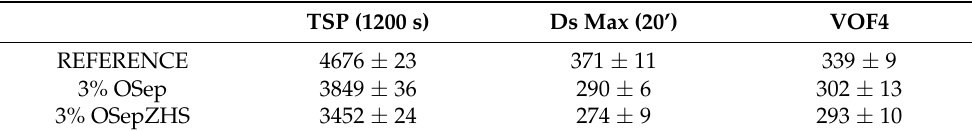
Table 4. Smoke chamber test results. TSP 1200 s: total smoke production after 1200 s, Ds max (20 (cid:48) ): maximum specific optical density obtained within the 20 min test period. VOF4: parameter of the rate of smoke production during the first four minutes of the test.